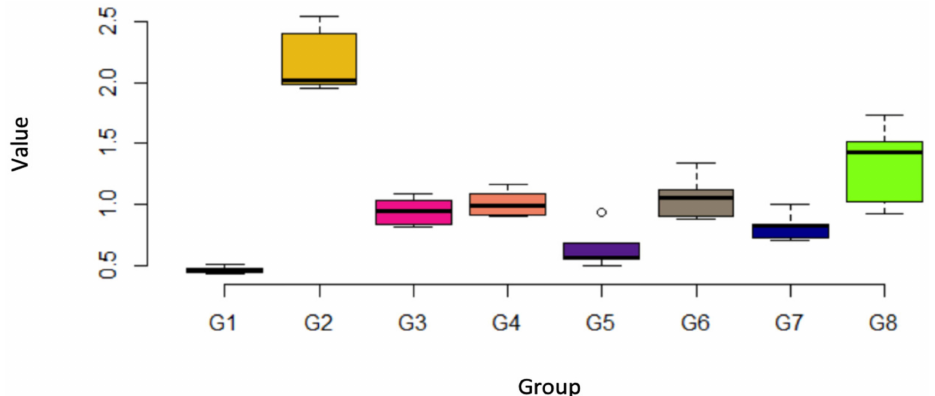
Figure 1. Boxplot of the treatments considered in the study.